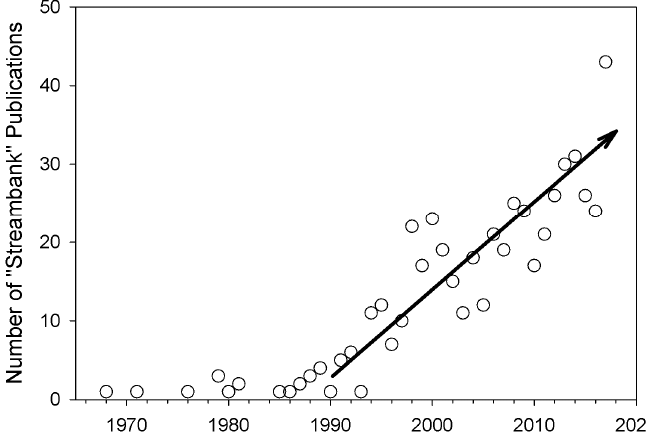
Figure 2. Number of publications on the topic of “streambank”. Data are extracted from the Institute for Scientific Information’s (ISI) Web of Science database. A total of 541 publications were identified under the topic of “streambank” as of August 2018.